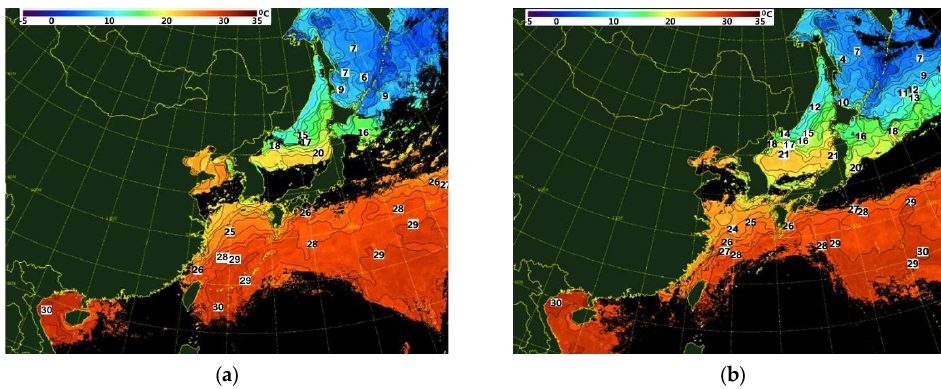
Figure 17. ( a ) Images taken at 09:00 LST, 8 July 2015, and ( b ) 09:00 LST, 9 July. Long black area oriented from southwest to northeast in ( a , b ) indicates the MLCT. STS Linfa moved to the warmest sea of 31 °C SST in the South China Sea passing Luzon Island in ( a , b ). TY Chan ‐ Hom also moved over the Kuroshio current of 31 °C SST to the northeast of the Philippines, being closer to the MLCT.